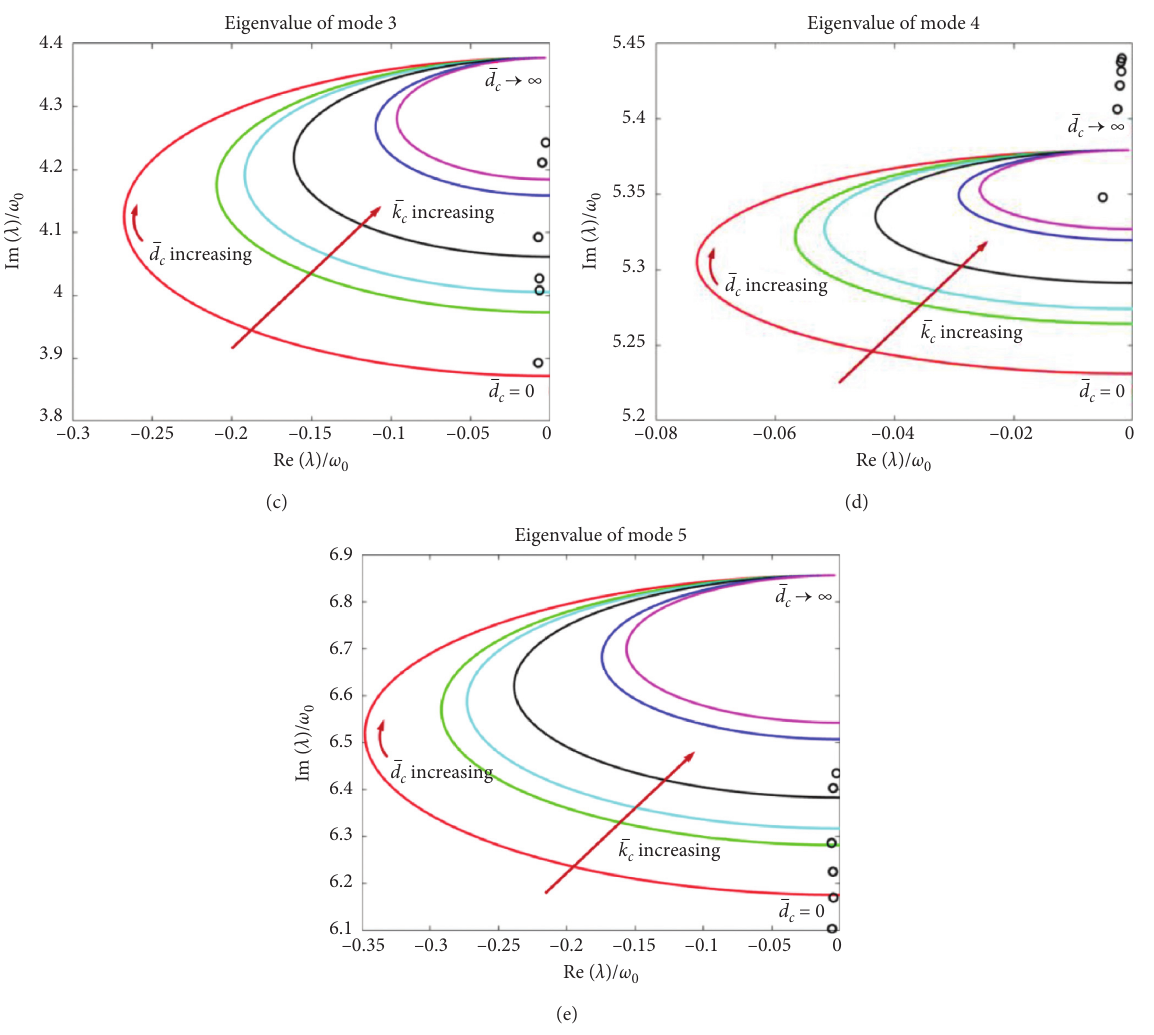
Figure 12: Root locus for varying joint stiffness (along the direction of the arrow, the dimensionless stiffness k � 0 . 13 , 0 . 17 , 0 . 18 , 0 . 21 , 0 . 33 , and0 . 37; the black circle denotes experimental c